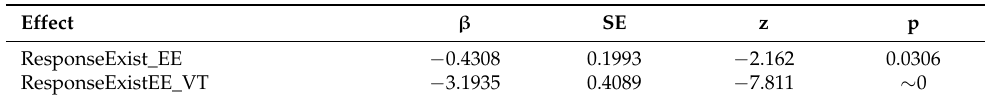
Table A16. Coefficient estimates for evidential existentiality norming study mixed-effects model.